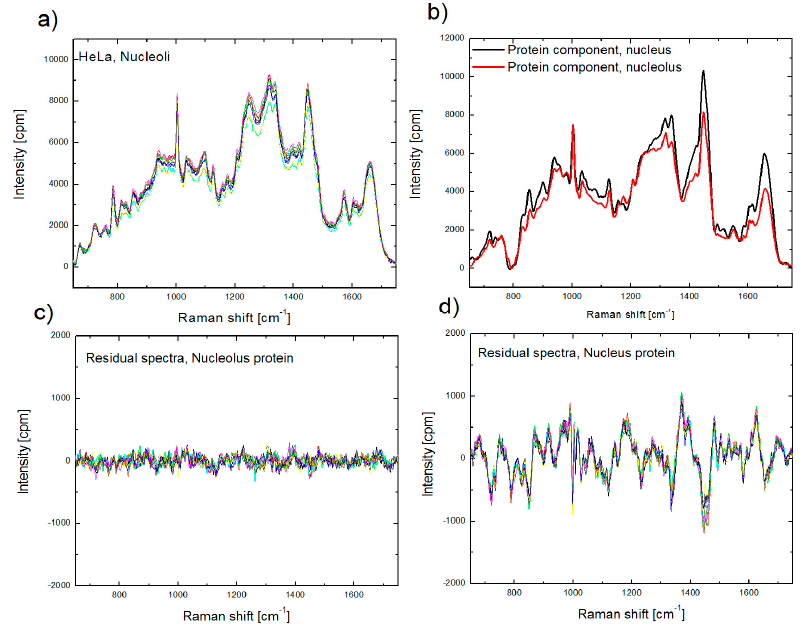
Figure 3. Raman spectra of nucleoli, collected from nine single cells ( a ); protein spectral component for nucleolus (red) and nucleus (black) used in BCA ( b ); residual spectra obtained after BCA of spectra, shown in ( a ), using proper (nucleolus) protein component ( c ) and improper (nucleus) protein component ( d ).